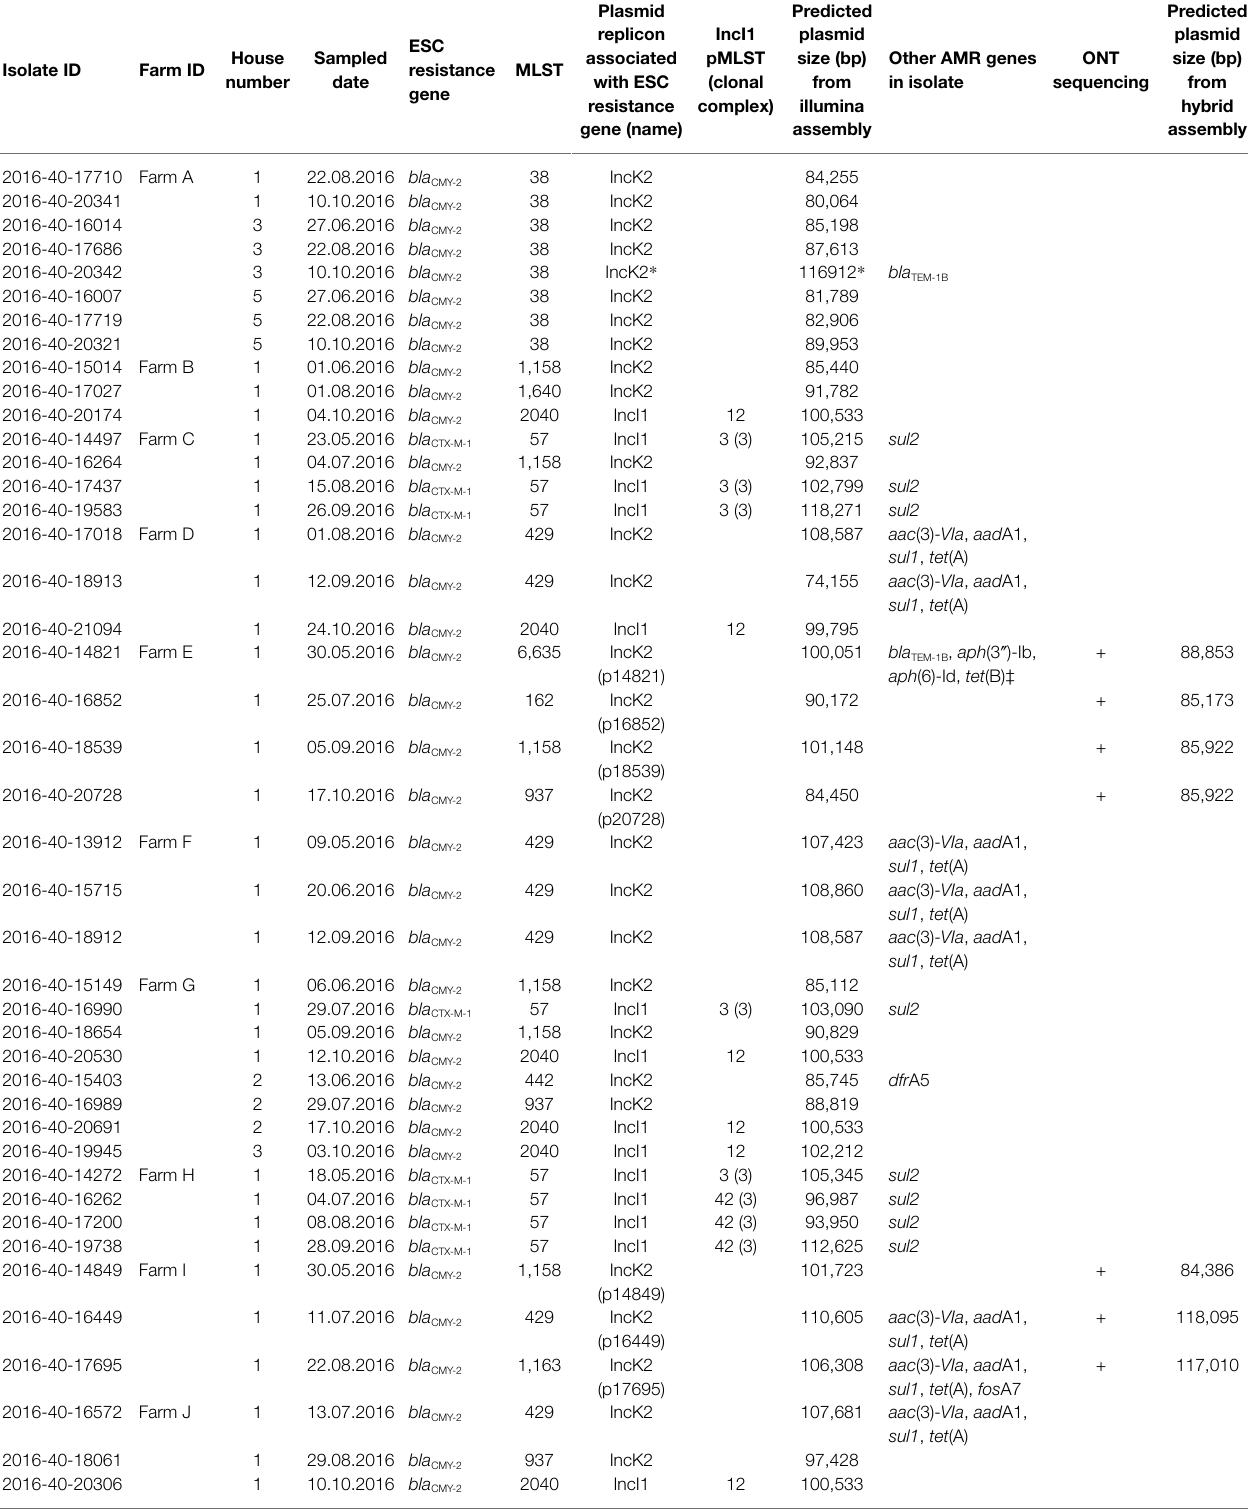
TABLE 1 | Overview of characteristics associated with extended-spectrum cephalosporin-resistant Escherichia coli originating from 42 broiler flocks reared on 10 broiler farms in Norway during May–October 2016.